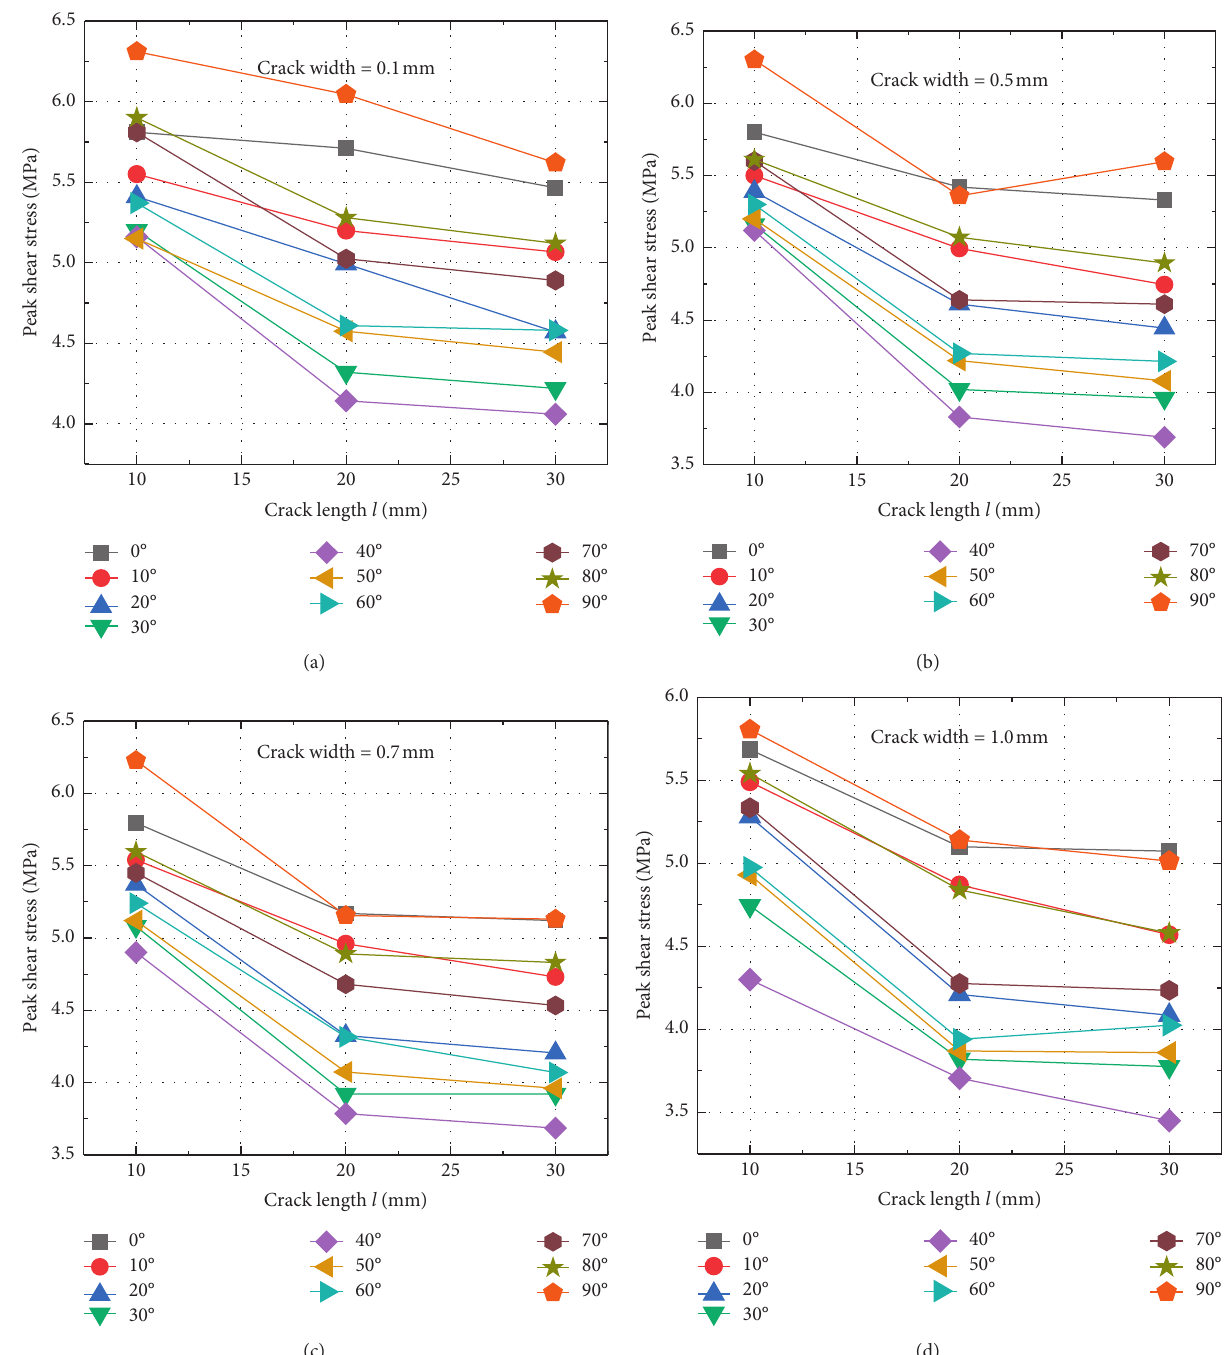
Figure 6: Relation curve between prefabricated fissures with different lengths and peak shear strength of